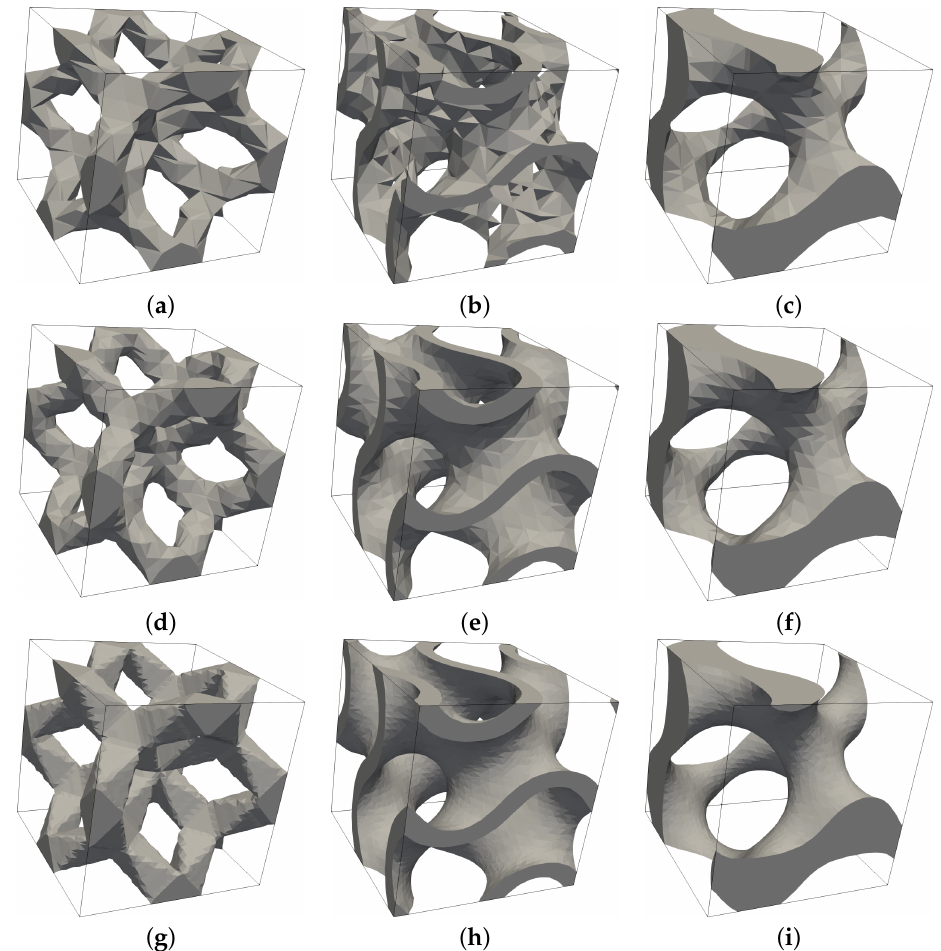
Figure 19. Influence of mesh refinement on approximation of solid phase by X-FEM: ( a – c ) subdivision into 10 × 10 × 10 brick elements, ( d – f ) subdivision into 15 × 15 × 15 brick elements, ( g – i ) subdivision into 35 × 35 × 35 brick